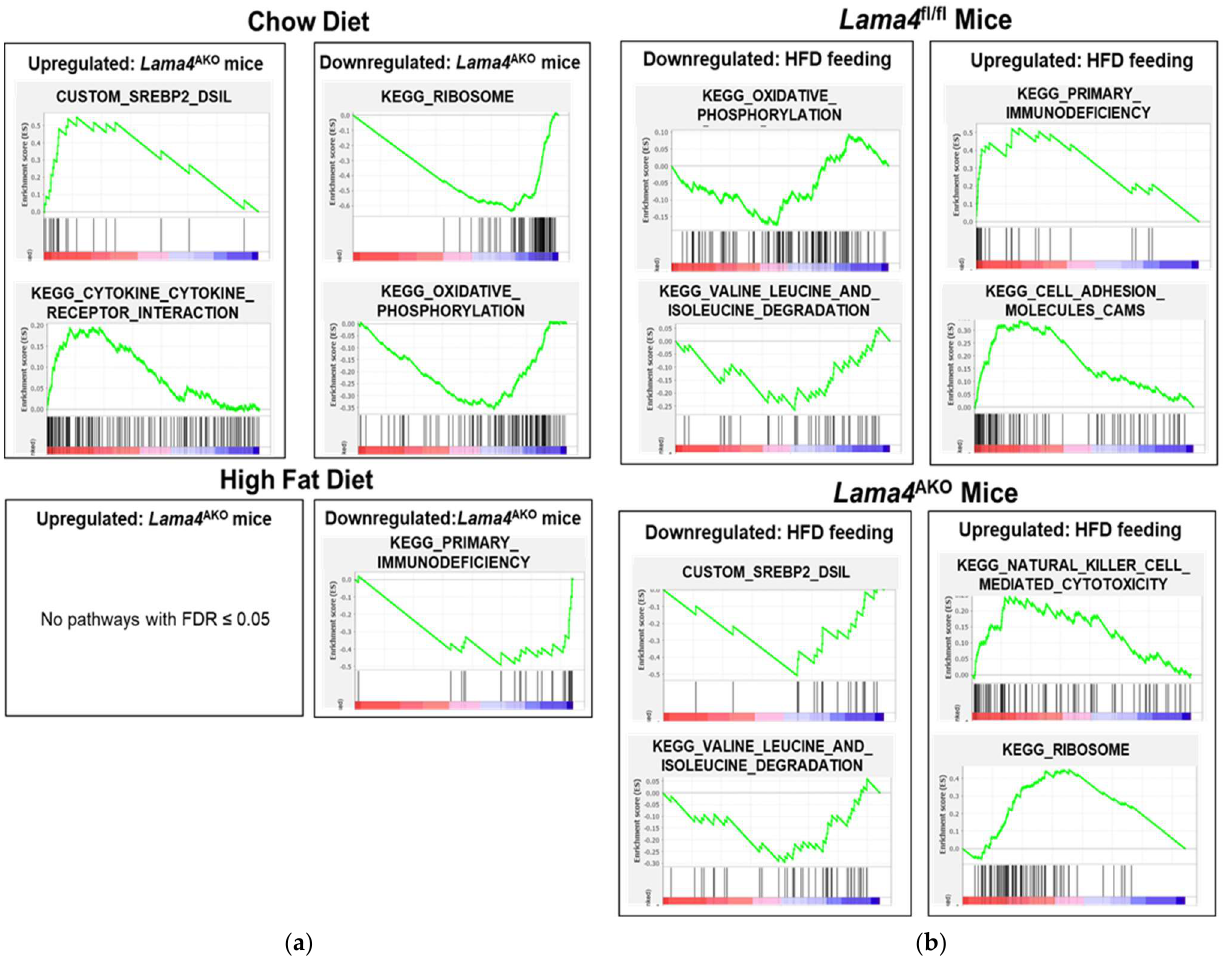
Figure 11. Enrichment plots of selected pathways significantly up-or down-regulated (FDR ≤ 0.05) in two or more diet or genotype comparisons as determined by GSEA and summarized in Figure 10. ( a ) Genotype comparisons revealed that sterol and immune pathways were upregulated, while ribosomal and oxidative phosphorylation pathways were downregulated, in chow-fed Lama4 AKO mice when compared to chow-fed controls. Conversely, no pathways were upregulated, while immune pathways were downregulated in HFD-fed Lama4 AKO mice when compared to controls. ( b ) Diet comparisons revealed significant downregulation of metabolism-related pathways and upregulation of inflammatory pathways upon HFD feeding compared to chow feeding in Lama4 fl/fl mice. A similar pattern of pathway changes was also observed in Lama4 AKO mice with HFD feeding .